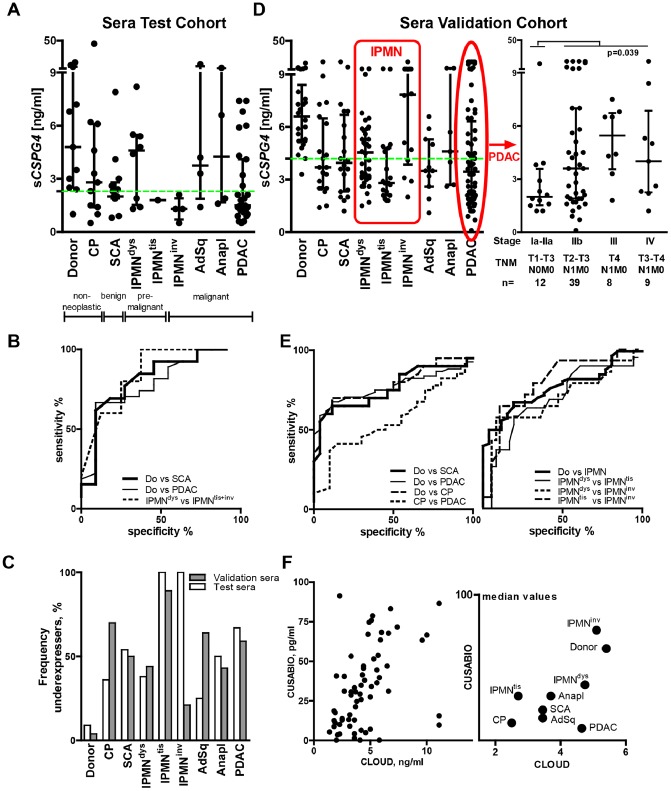
Reduction of serum CSPG4 (sCSPG4) in pancreatic diseases and its selective preservation following the ‘drop and restoration’ pattern in advanced IPMN and PDAC.(A) Systemic levels of sCSPG4 were determined by ELISA in sera (USCN/Cloud-Clone Corp. kit; n = 83) of healthy volunteers and patients with chronic pancreatitis (CP), serous cystadenoma (SCA), premalignant (dysplastic IPMNdys and IPMNtis), and malignant (IPMN with an associated invasive carcinoma, IPMNinv) forms of intraductal papillary-mucinous neoplasm, as well as in ductal (PDAC), adenosquamous (AdSq) and anaplastic (Anapl) carcinomas. The data are summarized to show individual values, median level, and interquartile range (IQR). (B) The ROC analyses of the ELISA data showed the discriminatory power of sCSPG4 levels for patients with different pancreatic diseases. The dotted green line represents the median level of the particular cohort used to estimate the frequency of the sCSPG4 underexpressers in the panel (C), as detailed in Materials and Methods. (D–E) Validation of ELISA findings in an independent cohort (n = 221). Red-bordered areas indicate subgroups depicting IPMN and PDAC progression. The patients’ characteristics and results of statistical analyses are presented in the main text and Tables 1 and 2. (F) Validation of ELISA findings with a different ELISA kit (CUSABIO; n = 64).